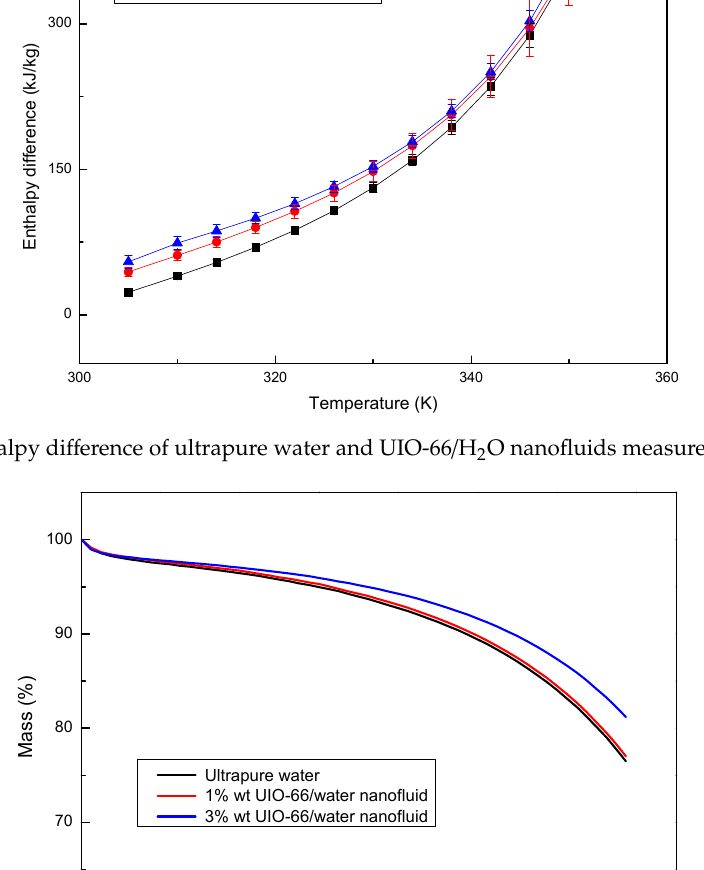
Figure 5. Mass changes of ultrapure water and UIO-66/H 2 O nanofluids measured by TG-DSC.